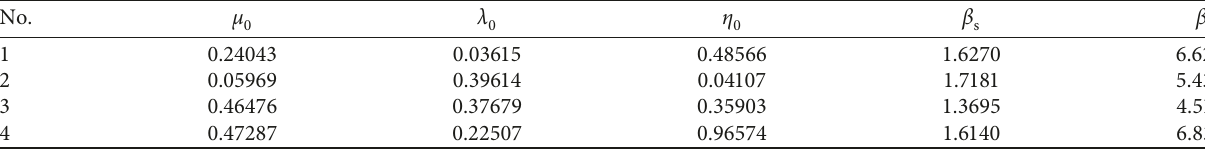
Table 2: Initial complex.